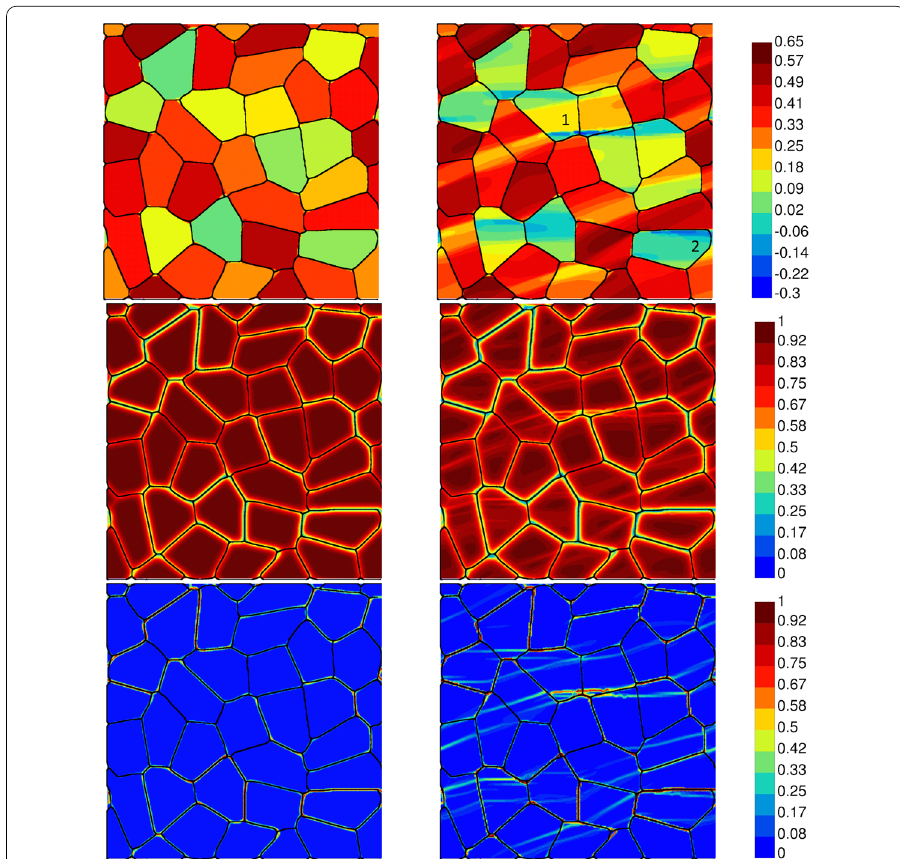
Fig. 5 The 32 grain microstructure before and after applied shear deformation. The initial values are shown to the left for θ (top), φ (middle) and curvature |∇ θ | (bottom). Top right shows the orientation distribution after shear deformation, middle right shows the corresponding phase-field φ and bottom right shows the curvature. The true maximum value of the curvature norm is around |∇ θ | = 1 . 7 µ m − 1 but it has been capped off at 1 µ m − 1 for a better visualization. In the simulation, only one slip system was active, resulting